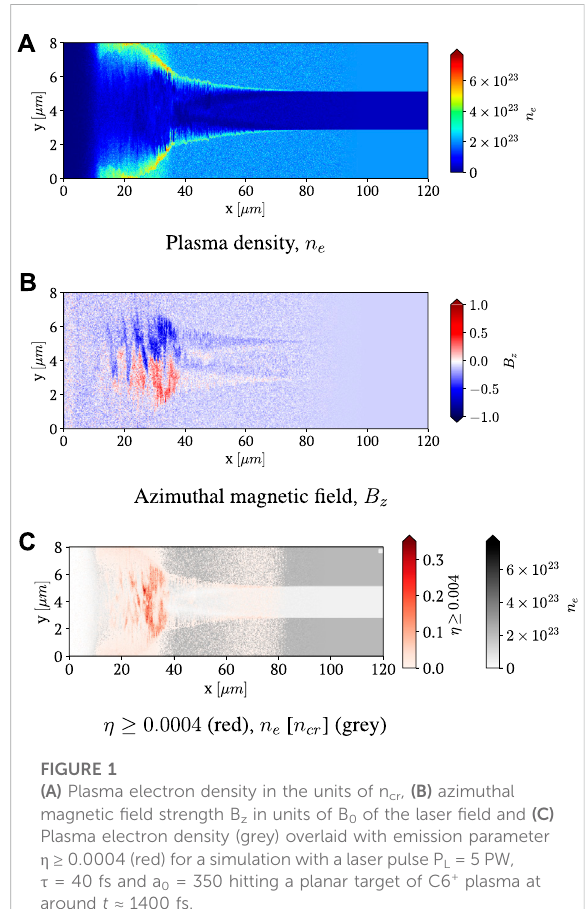
FIGURE 1 (A) Plasma electron density in the units of n cr , (B) azimuthal magnetic fi eld strength B z in units of B 0 of the laser fi eld and (C) Plasma electron density (grey) overlaid with emission parameter η ≥ 0.0004 (red) for a simulation with a laser pulse P L = 5 PW, τ = 40 fs and a 0 = 350 hitting a planar target of C6 + plasma at around t ≈ 1400